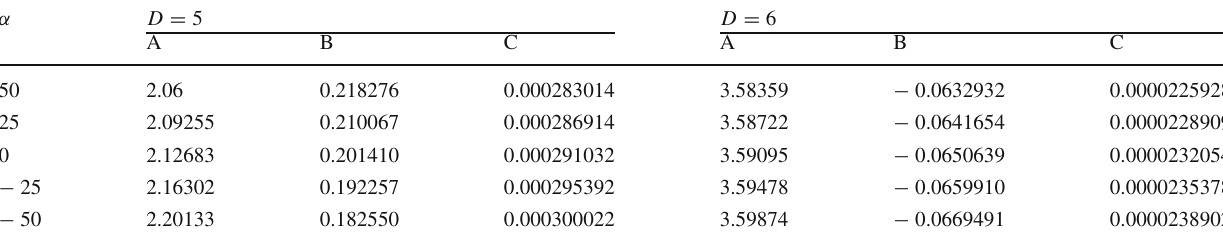
Table 1 Different values of parameters A, B and C for PSR J0348+0432 for different values of α in 5D and 6D